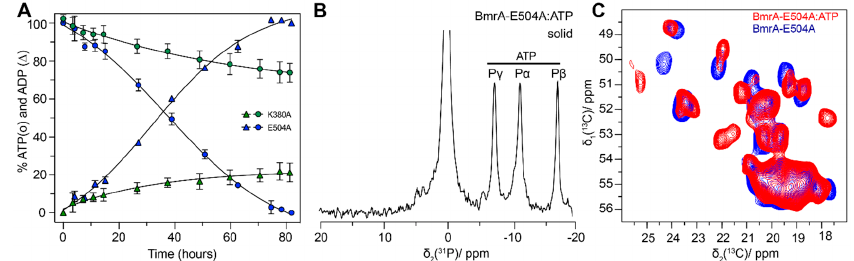
Figure 5. Pre-hydrolytic states using the system BmrA-E504A (catalytically inhibited). Percentage of ADP ( Δ ) and ATP ( ○ ) in the presence of the mutant BmrA-E504A (symbol filled in blue) or of the mutant, which does not bind the nucleotide, BmrA-K380A (symbol filled in green). BmrA-K380A was chosen as a negative control in order to exclude the possibility of an ATPase contaminant in the sample ( A ). 31 P 1D CP spectrum of BmrA-E504A:ATP ( B ). The overly of the alanine region of 13 C- 13 C- DARR spectra of BmrA-E504A (blue) and BmrA-E504A:ATP (red) ( C ). Results in panels ( A ) and ( B ) are original, and spectra in ( C ) were adapted from Lacabanne et al. 2019 [92] (http: // creativecommons.org / licenses / by / 4.0 /